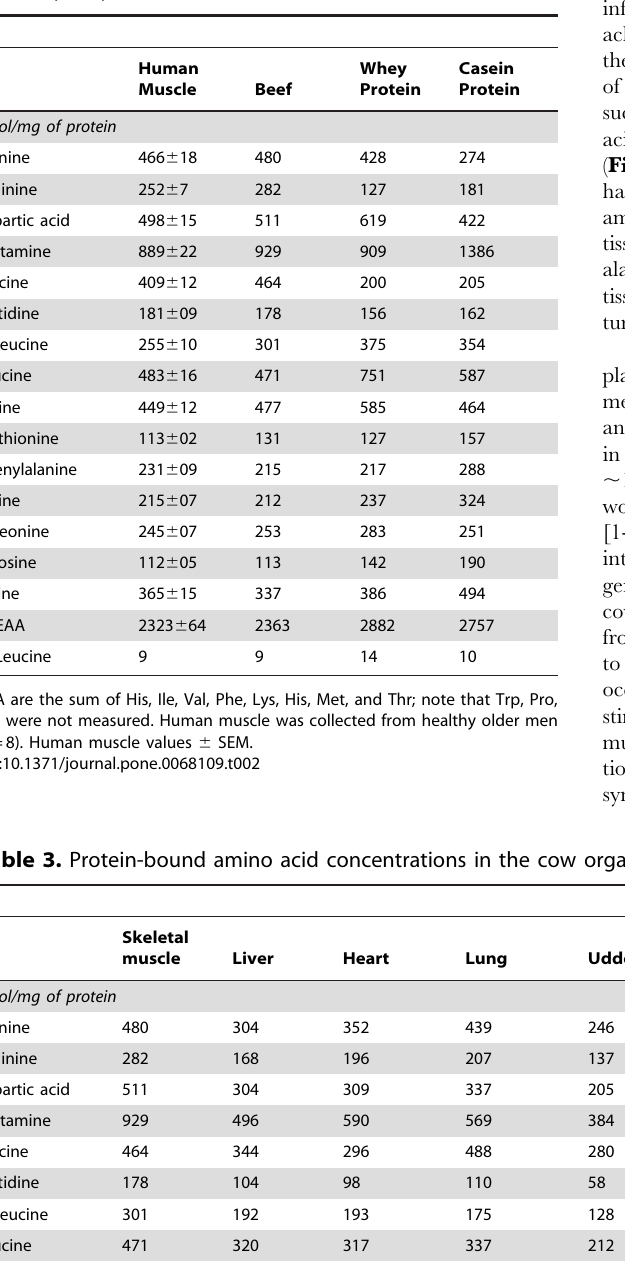
Table 2. Protein-bound amino acid concentrations in human skeletal muscle ( n =10) and in cow beef, whey and casein protein ( n =1).